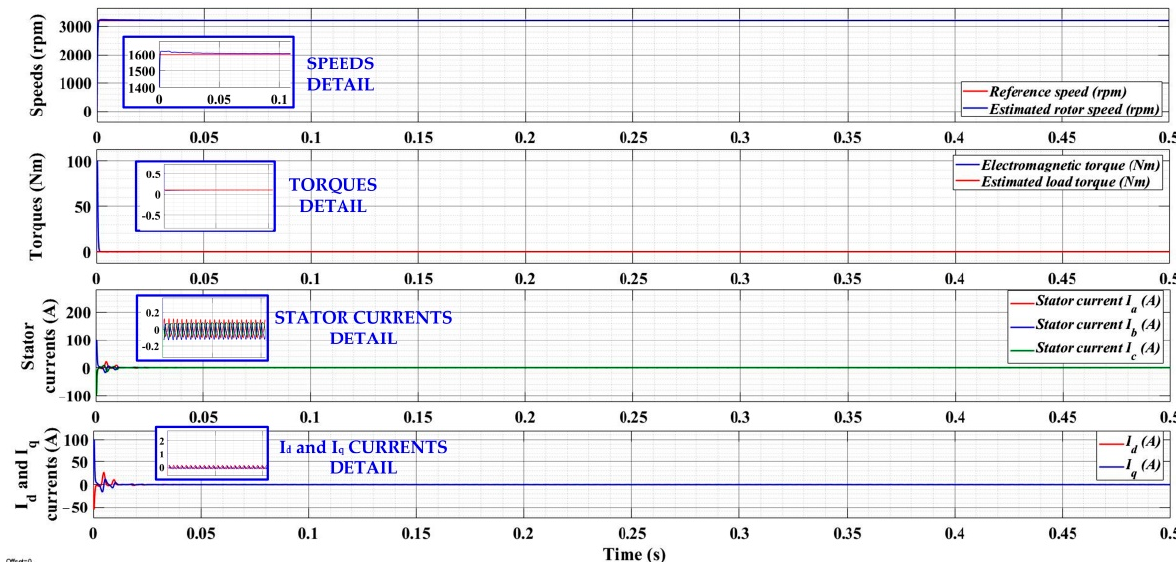
Figure 19. Time evolution for the numerical simulation of the PMSM control system based on the backstepping-PSO controller: ω ref = 1600 rpm, T L = 1 Nm, K ω = 0.01, K I ω = 140, K q = 5000, K Iq = 50, γ = 0.01, K d = 300, and K id = 300.